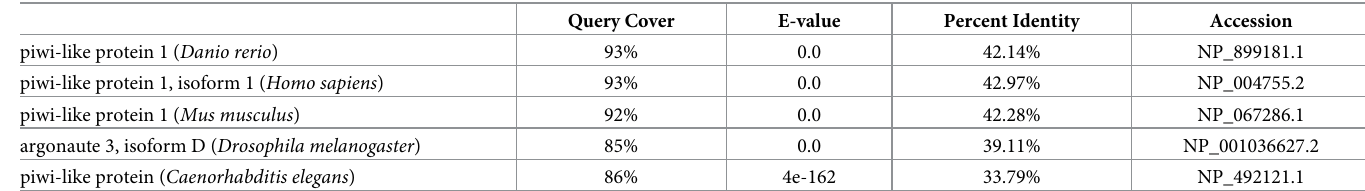
Table 3. The amino acid sequence of BgPiwi isoform 1 is conserved in comparison to those from other organisms.